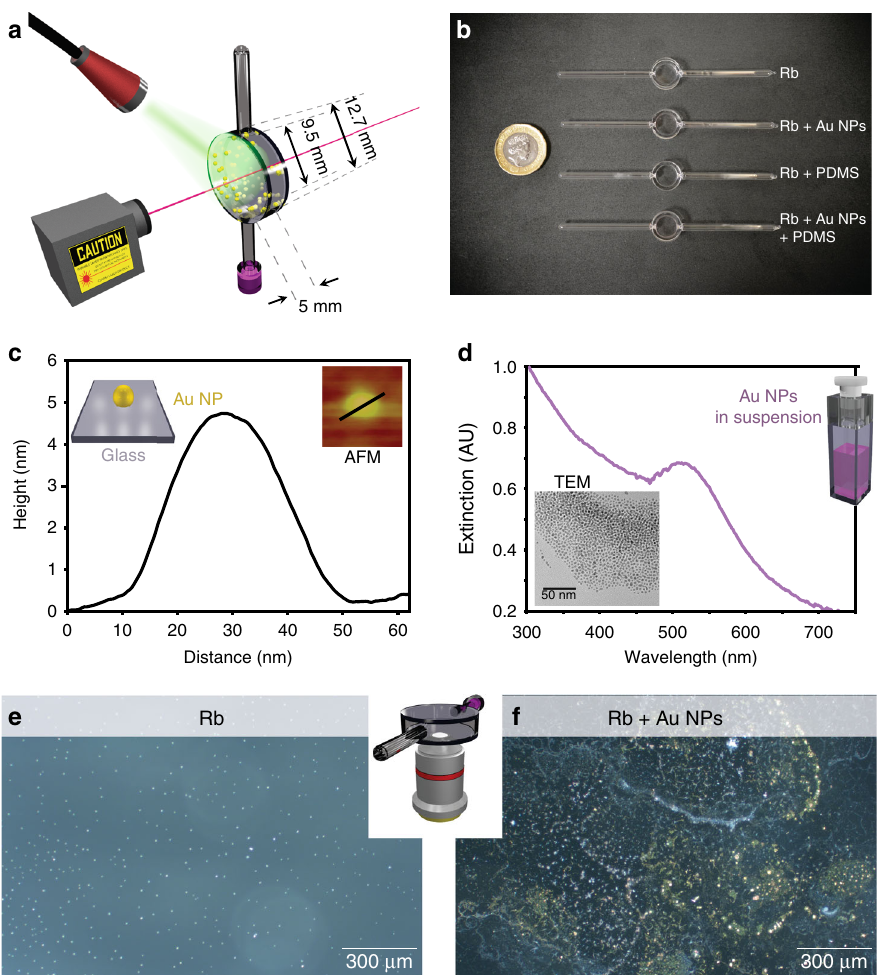
Fig. 1 A coating for atomic vapour cells, based on plasmonic nanoparticles. a Schematic diagram of our experiment. b A photograph of the fabricated coated and reference cells. c Line pro fi le of the atomic force microscopy (AFM) image (in inset) of a 5 nm Au nanoparticle (NP) deposited on a glass substrate. d Extinction spectrum of the Au NPs in hexane solution. The inset shows transmission electron microscopy (TEM) image of the Au NPs deposited on a grid. e and f Dark fi eld optical microscopy images of the interior wall of the reference and Au-coated cells, respectively. Images were acquired through a fl at cell window as illustrated in the inset, with a x5 objective inset. In the micrograph, the pale blue dots correspond to scattering from Rb crystalline particles, condensed on the inside window. By contrast, Fig. 1f shows a similar dark fi eld micrograph from the vapor cell with Au NPs. The latter can be seen as green patches and yellow aggregates. These Rb cells are then placed within the optical setup.